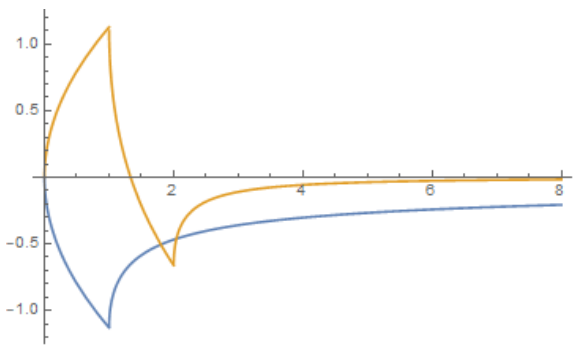
Figure 3. The fractional derivatives C D t N 01 (blue) and C D t B 1